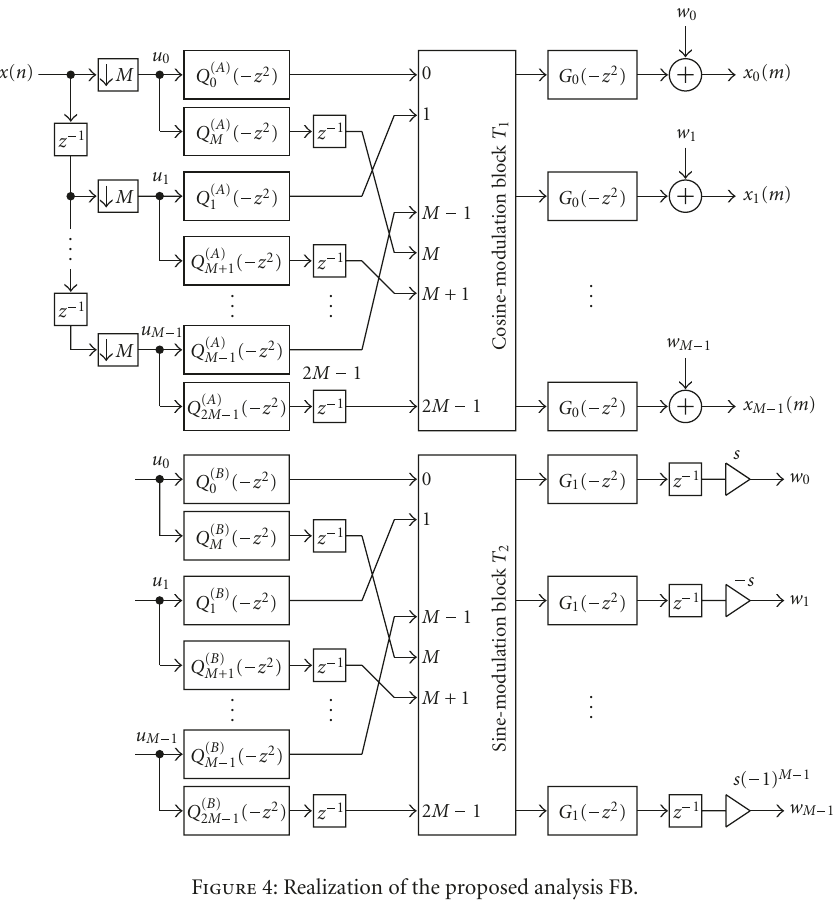
Figure 4: Realization of the proposed analysis FB.